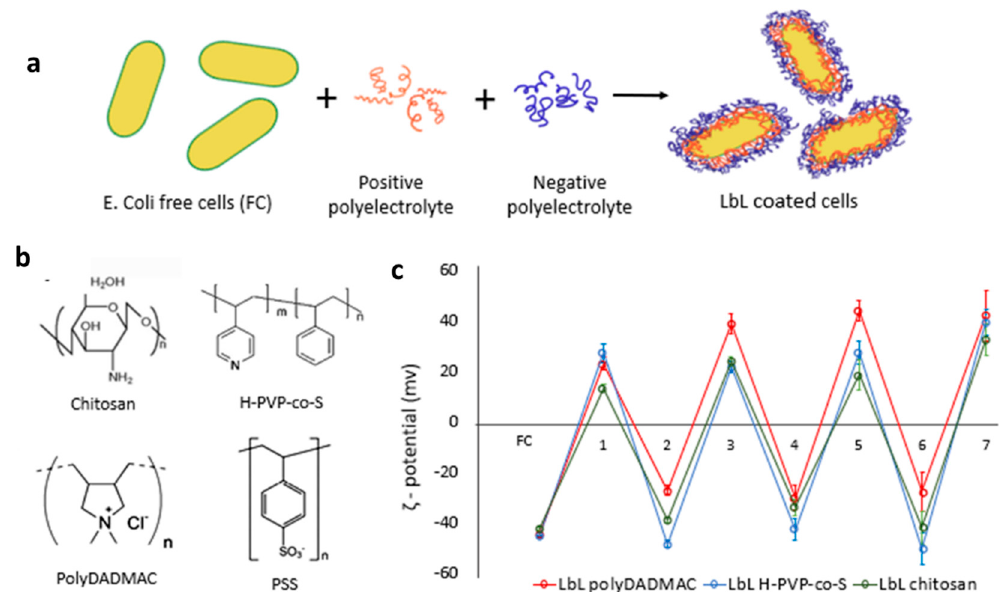
Figure 2. ( a ) Illustration of the LbL deposition of polyelectrolytes. ( b ) Chemical structure of the polyelectrolytes used in this study. ( c ) ζ potential measurements showing charge reversal after each layer added.